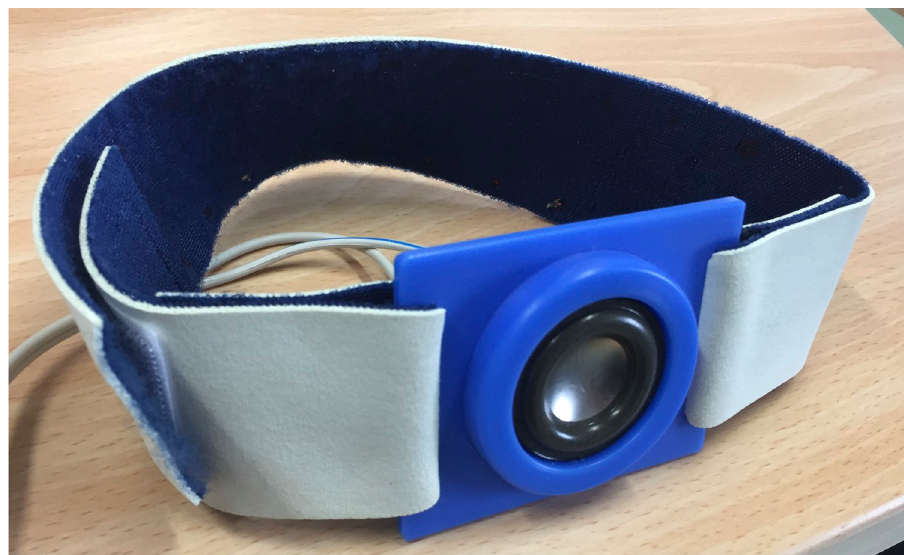
Fig 1. Speaker-type